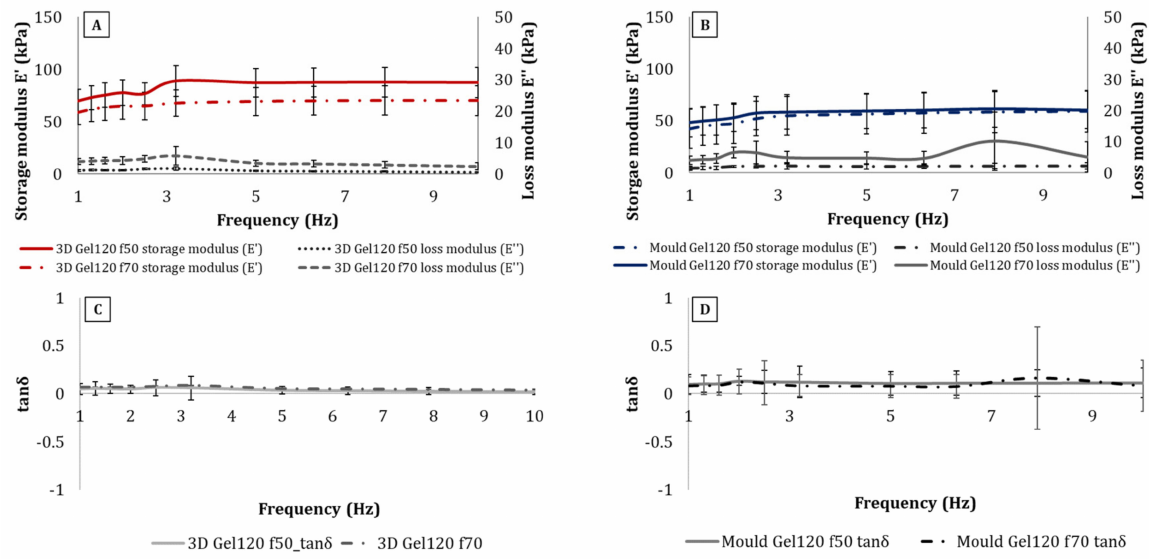
Figure 9. Evaluation of the storage modulus ( A , B ), loss modulus ( A , B ), and tan δ ( C , D ) of 3D-printed ( A , C ) and mould-casted ( B , D ) scaffolds through multifrequency